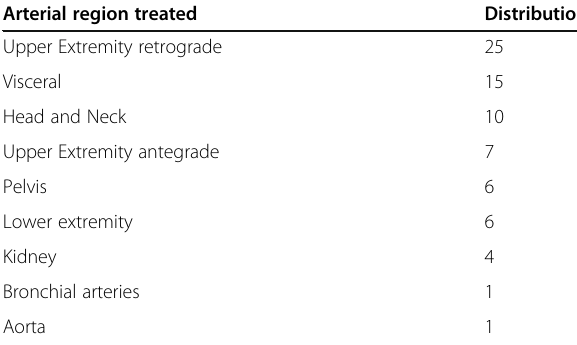
Table 2 Treated vascular territories